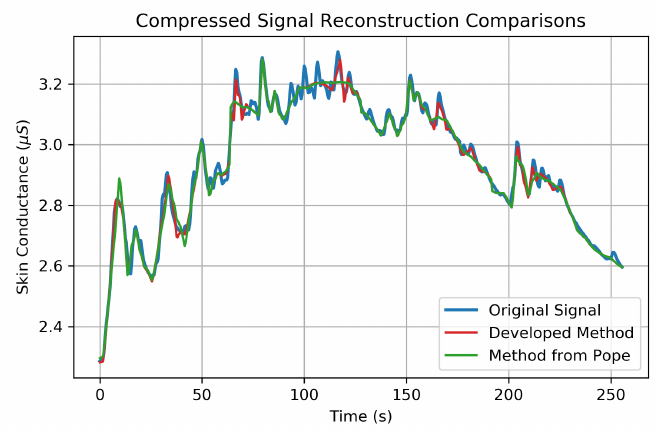
Figure 7. An EDA signal is shown in blue along with a reconstructed EDA signal using the newly developed compression method in red. The previous compression method from Pope et al. 2018 [9] is shown in green for comparison. The original signal is compressed from a data rate of 64 bits/s to 3.75 bits/s in both methods (CR = 17.1 × ) (The input data rate in [9] used a signed 16-bit representation of skin conductance values instead of the more appropriate 32-bit float representation used here and in [10]. Therefore, the CRs reported in [9] should be doubled for comparison.) The developed method in red is able to encode 18 total W 4 coefficients, whereas the previous method in green is only capable of encoding the top 14 coefficients leading to a 31.8% improvement in root mean square error (RMSErr). Both reconstructions are composed of four, 64-s compression/decompression cycles spliced